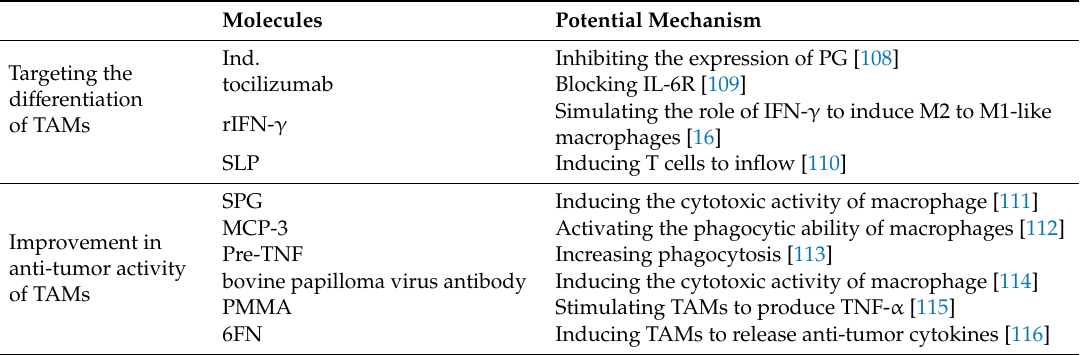
Table 5. Molecules for Therapy by Targeting